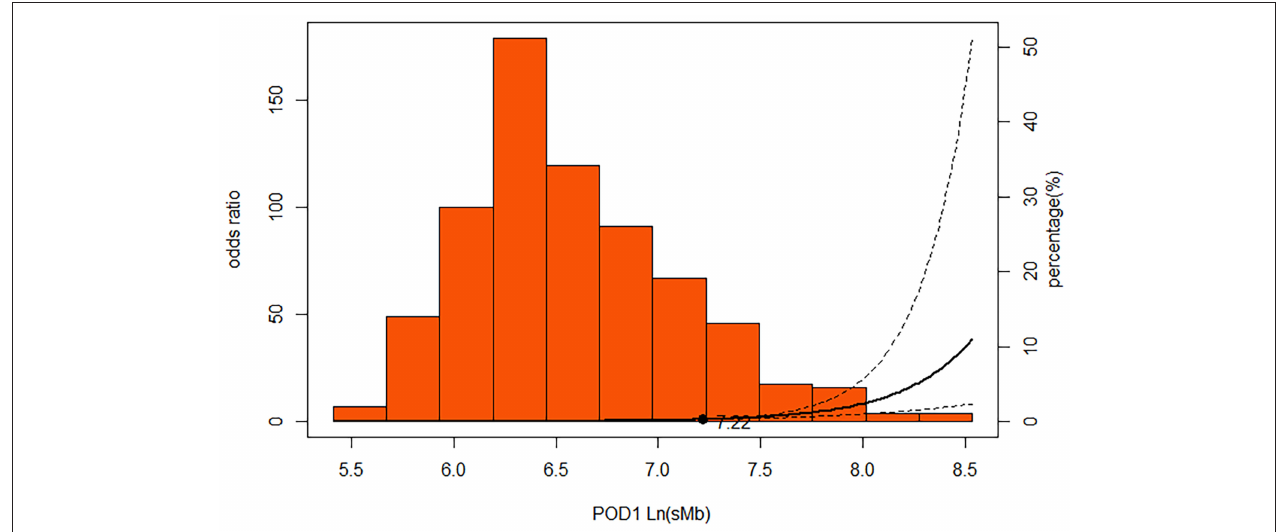
FIGURE 2 | Multivariable-adjusted restricted cubic spline demonstrating that the adjusted association of POD1 Ln(sMb) with severe AKI was non-linear in persons underwent TAR with FET. Solid line represents ORs; dotted lines, 95% CIs. The extreme 5% of the data distribution was excluded to avoid implausible extrapolation from the extremes of the data. The spline function was adjusted for Model b . Model b : age, sex, BMI, hypertension, preoperative Egfr and preoperative WBC, surgery duration, cardiopulmonary bypass duration, the lowest rectal temperature and lactate.